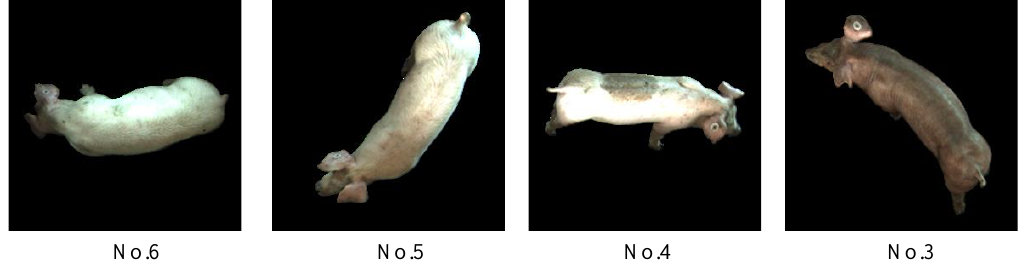
Figure 16. Examples of pig individuals in dataset 1.